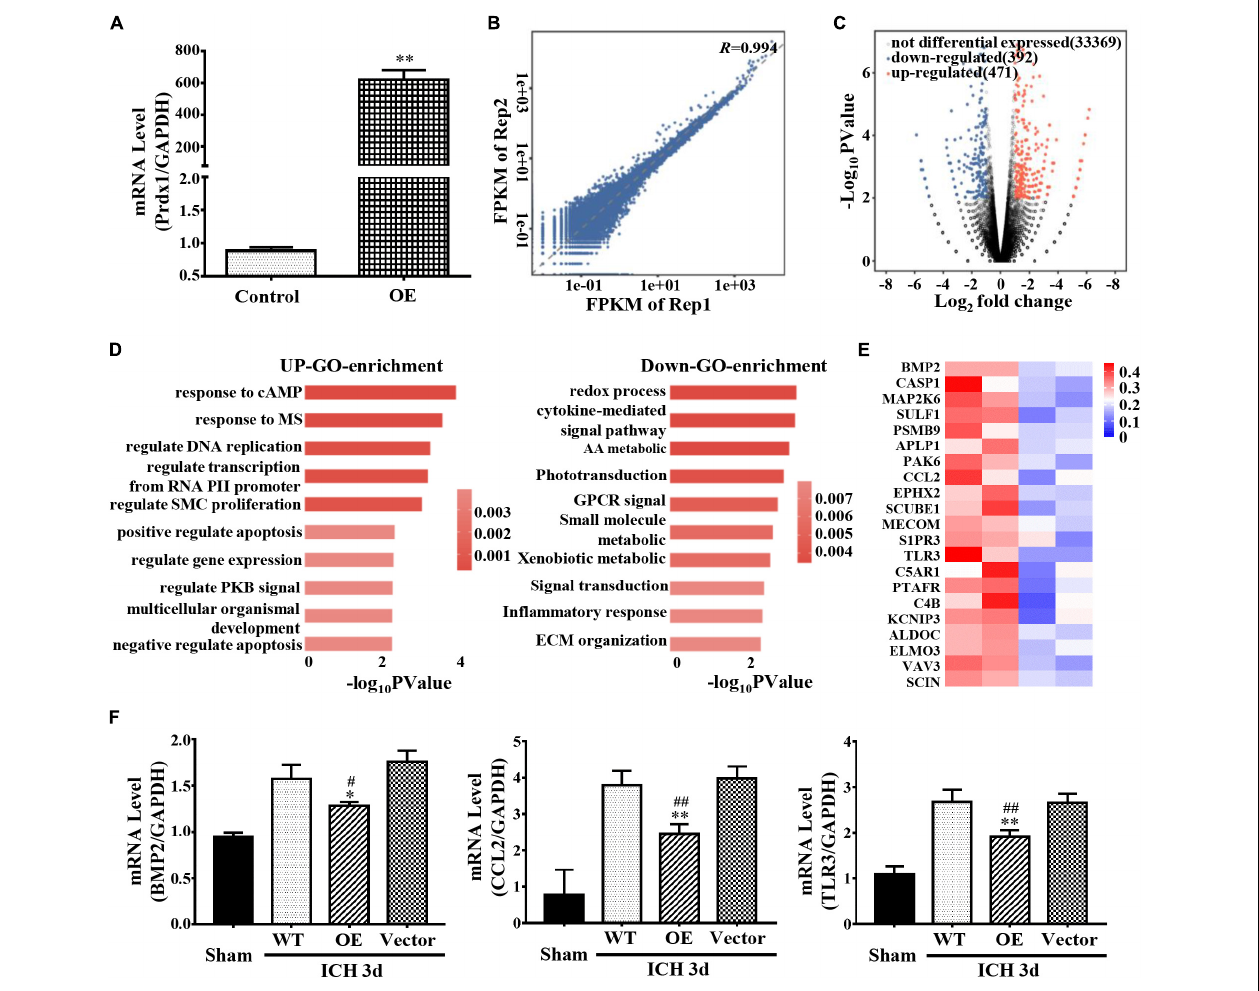
FIGURE 6 | Prdx1 affects inflammation- and apoptosis-related mRNA stability. (A) Prdx1 expression in control HeLa cells and in the Prdx1-OE group was detected by qRT-PCR ( F = 8.494, t = 40.635, ∗∗ P < 0.01 versus Control). (B) Scatter plots and correlation coefficients of two biological replicates of RNA-seq. (C) Volcano map: red dot indicates a gene that is upregulated after Prdx1 overexpression, black dot indicates a gene with no significant change, and blue dot indicates a downregulated gene. (D) Gene ontology (GO) analysis of Prdx1-dependent DEGs. Significantly enriched GO terms of genes. The x -axis indicates the enrichment P -value on a − log10 scale; the y -axis indicates terms. (E) Heat map showing that apoptosis- and inflammation-related genes were significantly decreased after Prdx1 was upregulated in HeLa cells. (F) qRT-PCR was performed in four groups 3 days after ICH (BMP2: F = 8.949, df = 3, ∗ P < 0.05 versus Vector, # P < 0.05 versus WT, n = 3; CCL2: F = 33.103, df = 3, ∗∗ P < 0.01 versus Vector, ## P < 0.01 versus WT, n = 3; TLR3: F = 39.330, df = 3, ∗∗ P < 0.01 versus Vector, ## P < 0.01 versus WT, n =